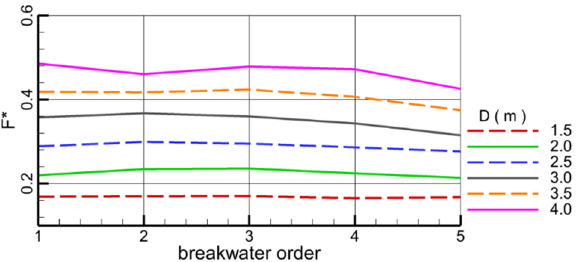
Figure 14. The maximum forces on the breakwaters with different diameters.